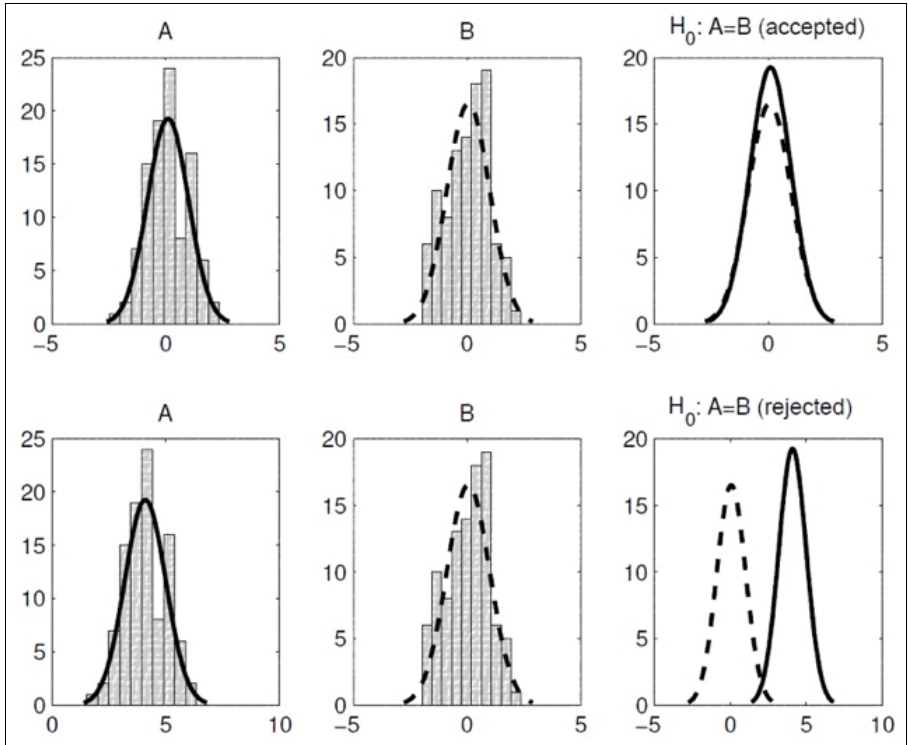
Figure 4. Hypothesis testing. On the top row, the test fails at rejecting the null-hypothesis (i.e., H 0 is accepted) as the algorithms A and B have statistically similar distributions. On the bottom row, H 0 is rejected as A and B are two different stochastic processes with statistically different